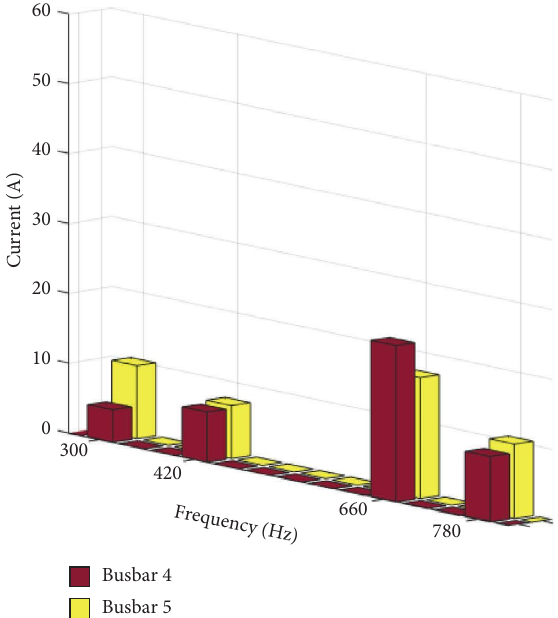
Figure 7: Case 2-Harmonic Current Spectrum in busbars 4 and 5.